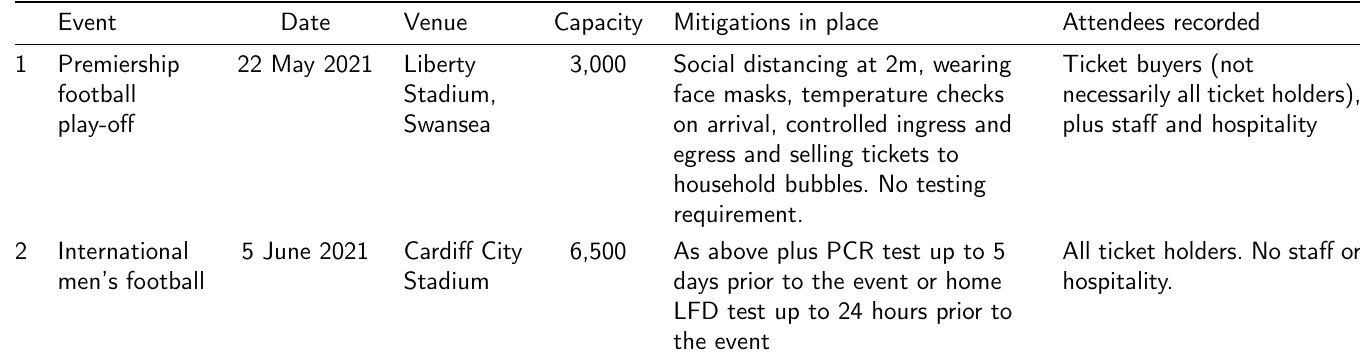
Table 1: Description of the two test